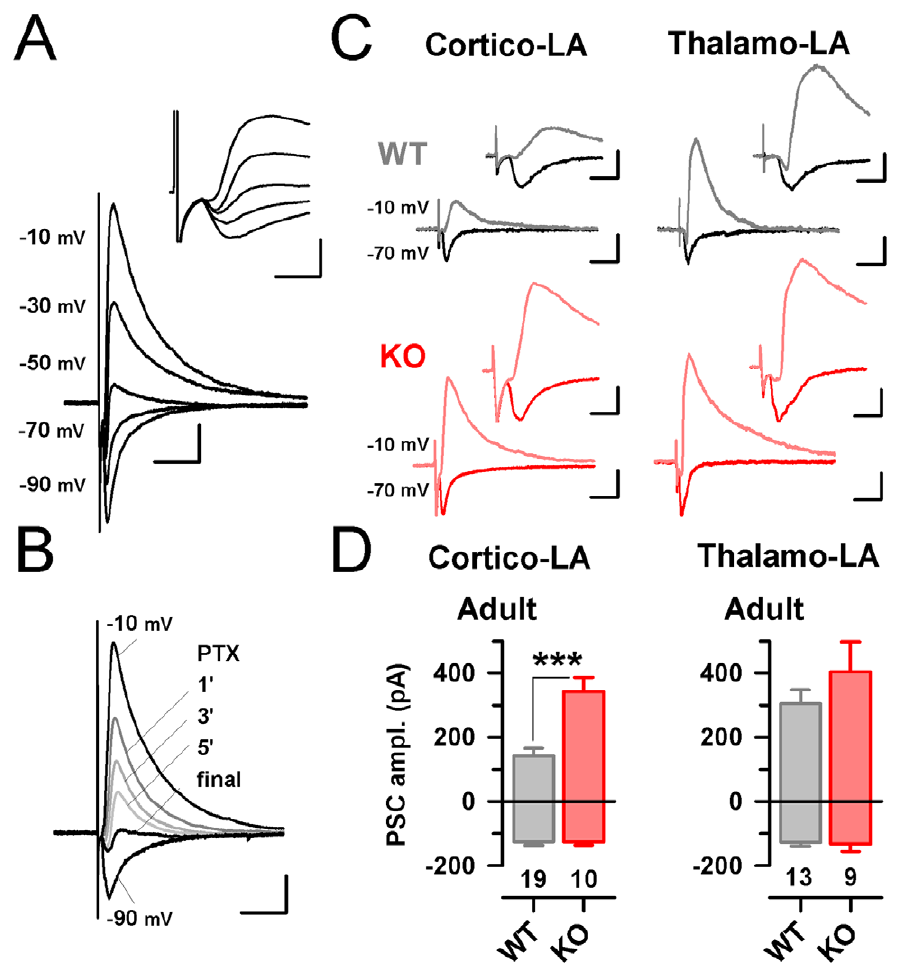
Figure 4. Synaptic elimination is restricted to the AMPA component at Cortico-LA synapses. A: Typical traces obtained at Cortico-LA synapses at various membrane potentials (indicated on the left). Scale bars: 100 pA and 20 msec. Top inset: enlargement of the recording. Note that the outward current is delayed of few milliseconds. Scale bars: 200 pA and 7 msec. B: Typical synaptic responses obtained in absence (black line) and presence of 100 m M Picrotoxin (grey lines). Note the complete blockade of the outward current at 2 10mV membrane potential. Scale bars: 150 pA and 40 msec. C: Left: typical synaptic currents recorded at 2 70 and 2 10 mV at Cortico-LA synapses in adult WT (grey) and KO (red). Right: typical synaptic currents recorded at 2 70 and 2 10 mV at Thalamo-LA synapses in adult WT (grey) and KO (red). Scale bars: full traces: 100 pA and 50 msec. Insets: 100 pA and 6 msec. D: Bar graphs summarizing the evolution of the EPSC (bottom bars) and corresponding FF-IPSC (top bars) in WT (grey) and KO (red) mice. The number of recorded cells is indicated. ***: p , 0.001.